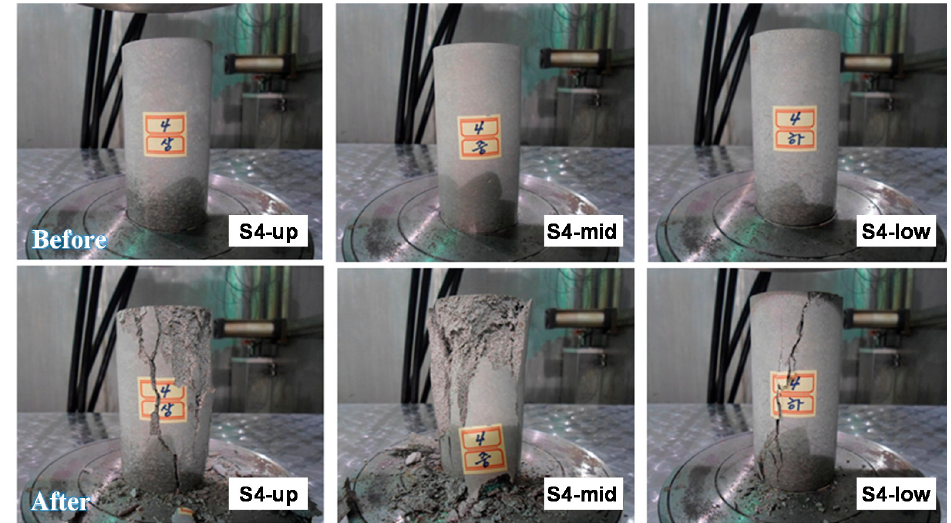
Figure 6. Irradiated samples before and after the compressive strength tests.